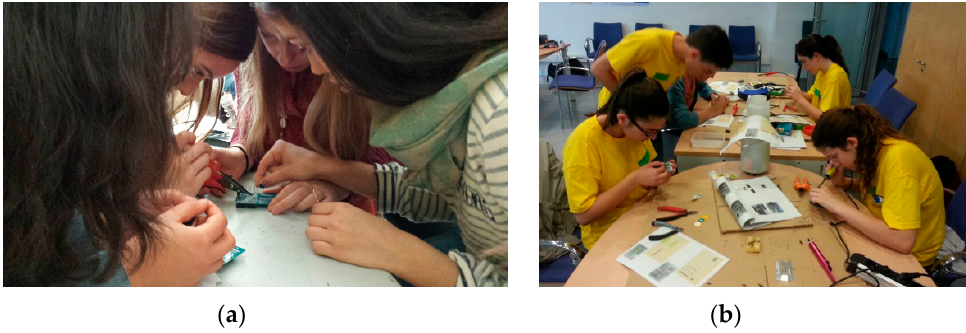
Figure 14. Students from Sant Carles de la Rapita ( a ) and Mollet ( b ) building their own KdUINOs.